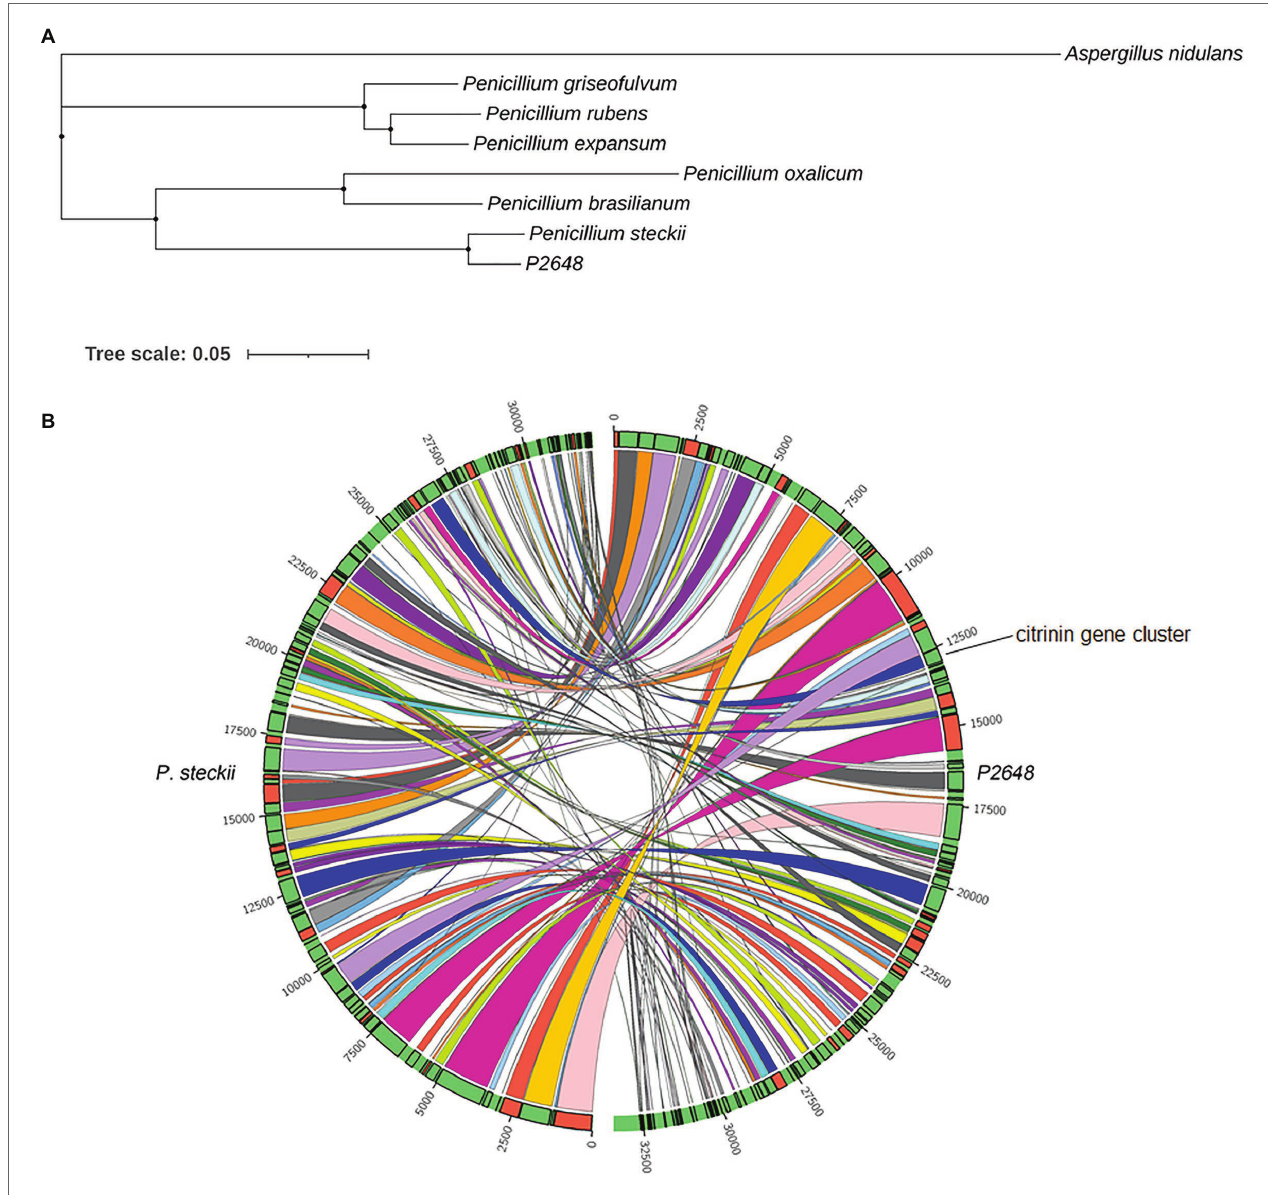
FIGURE 1 | Phylogenetic and synteny analysis of P2648 with other fungal species. (A) The maximum likelihood phylogeny was constructed inferred from the amino acid sequences of 5,884 single-copy genes by IQ-TREE. The phylogenetic tree was displayed by using iTOL. The single-copy genes were obtained by OrthoFinder tool. Aspergillus nidulans from Aspergillus genus was used as the outgroup; (B) Sequence-synteny analyses between marine-derived P2648 and soil-species, and the Circo plots represent syntenic blocks between P2648 and Penicillium steckii